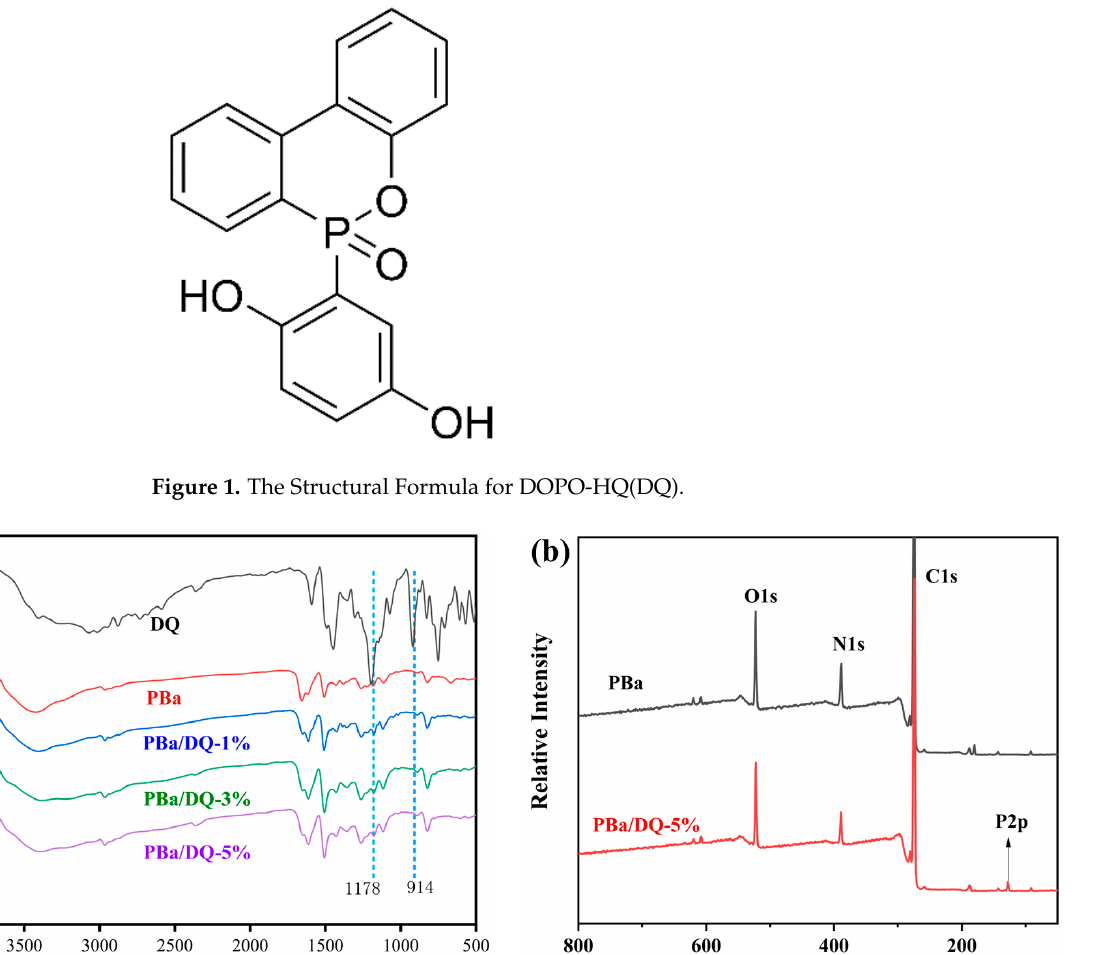
Figure 2. ( a ) The FITR Spectroscopy and ( b ) XPS of Aerogels.